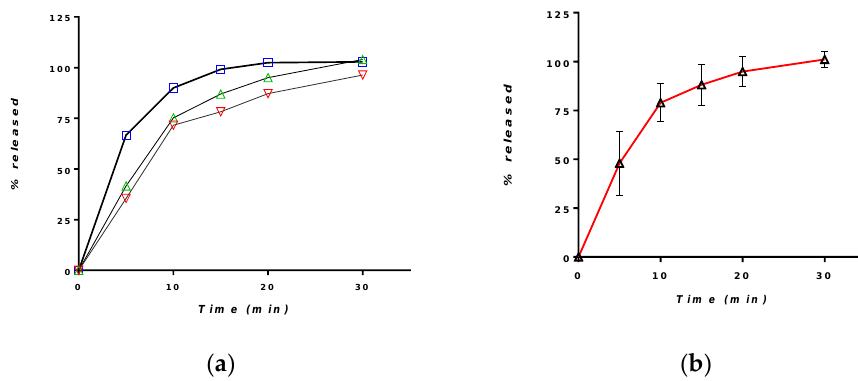
Figure 9. Release of CAP from the CAP- β -CD in HCl 0.01N ( a ) individual curves and ( b ) mean profile.